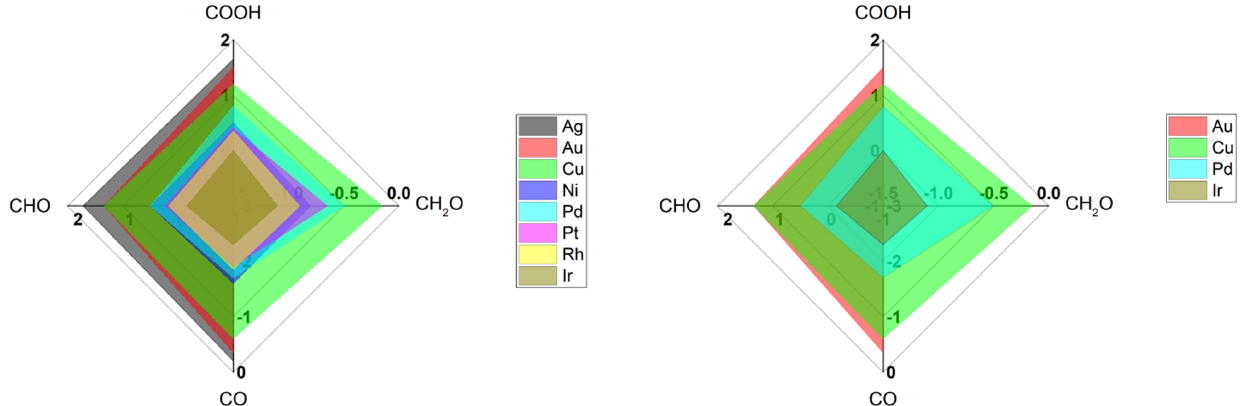
Figure 8. Radar plot for the binding energies for various key intermediate species for reduction of CO 2 into hydrocarbons on various metal surfaces. The extracted values are found in Nørskov’s paper [36].